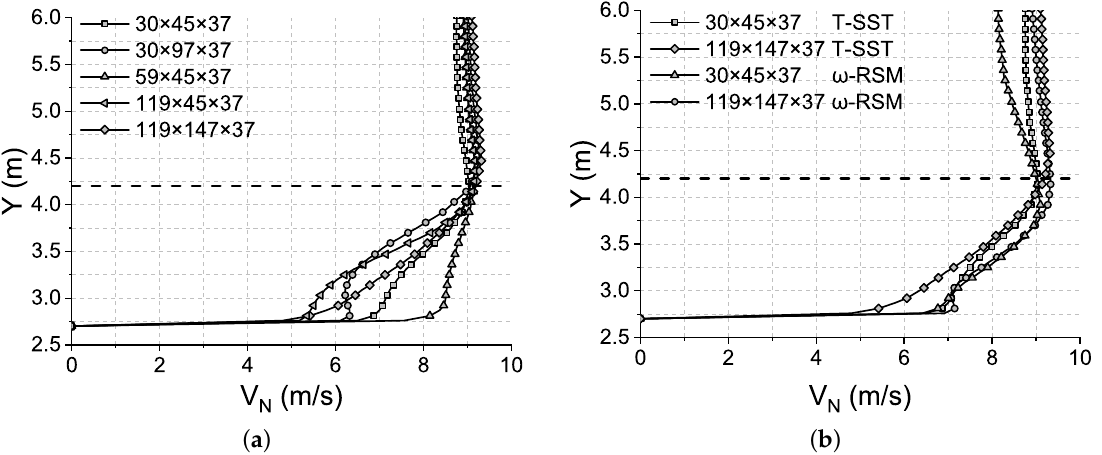
Figure 5. Verification of nacelle wind speed. ( a ) Mesh independence studies. ( b ) Turbulence model independence